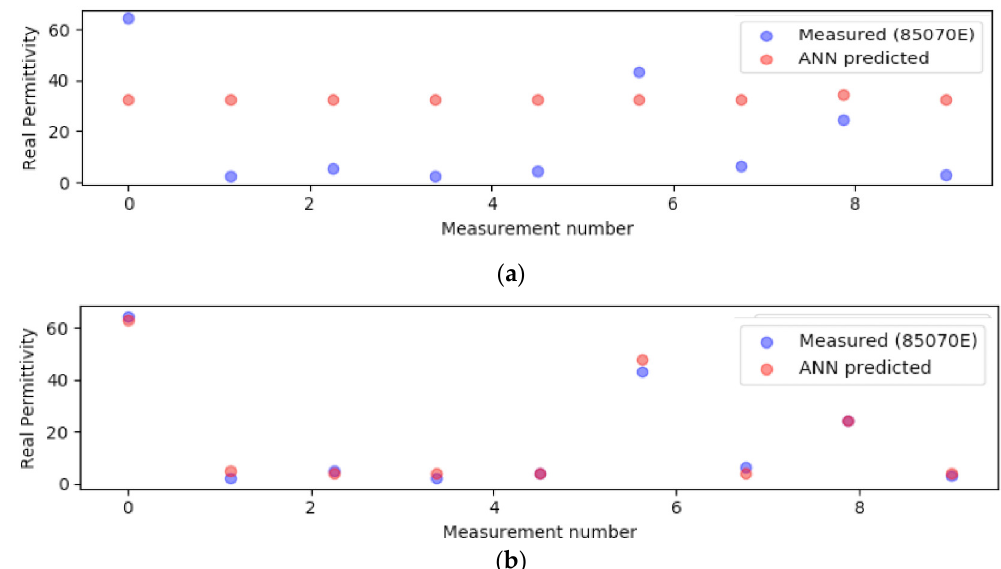
Figure 5. Two example plots showing model performance on randomly selected validation data: ( a ) a model in which the parameters were not refined; ( b ) the same model with refined parameters, showing vastly improved performance.